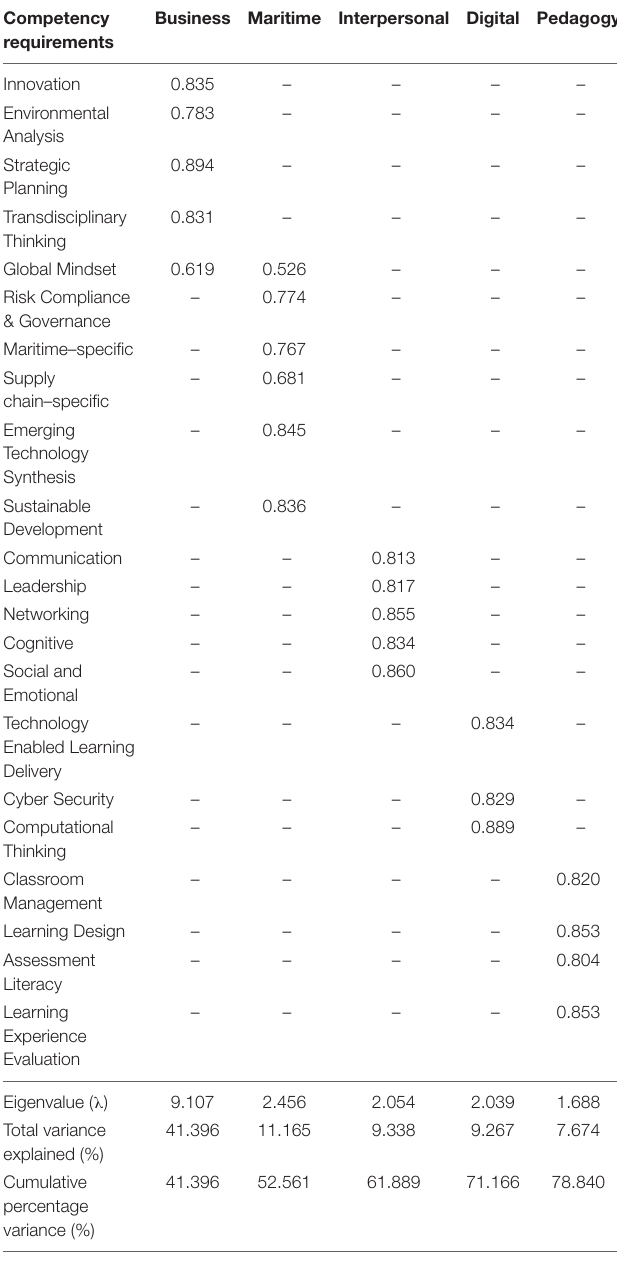
TABLE 5 | Exploratory factor analysis – rotated component